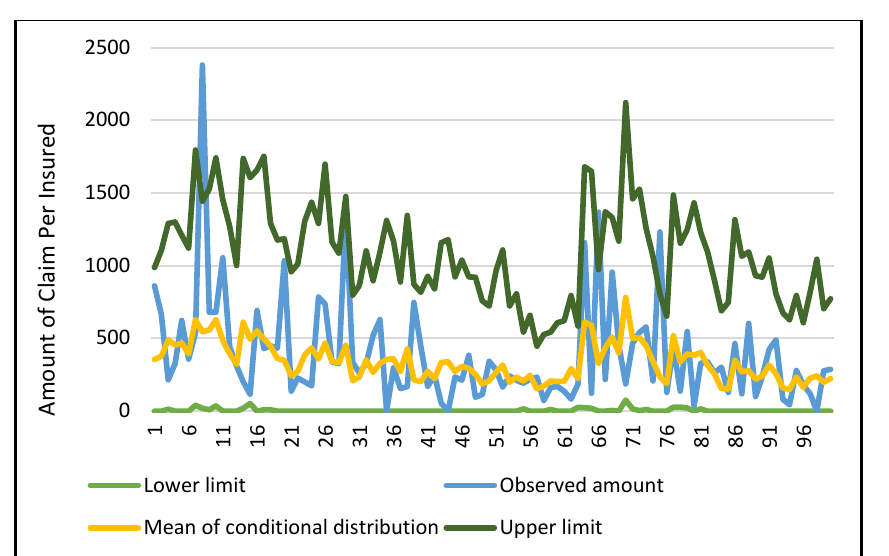
Fig. 5. Lower and upper limits of the first 100 prediction intervals for the amount of claim per insured ( 𝛼 = 0.05 , out-of-sample